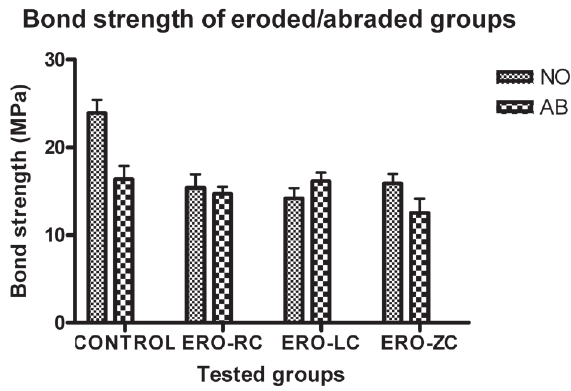
Figure 3- Bond strengths (MPa) for all tested conditions; comparing each eroded challenge in abraded and not abraded conditions